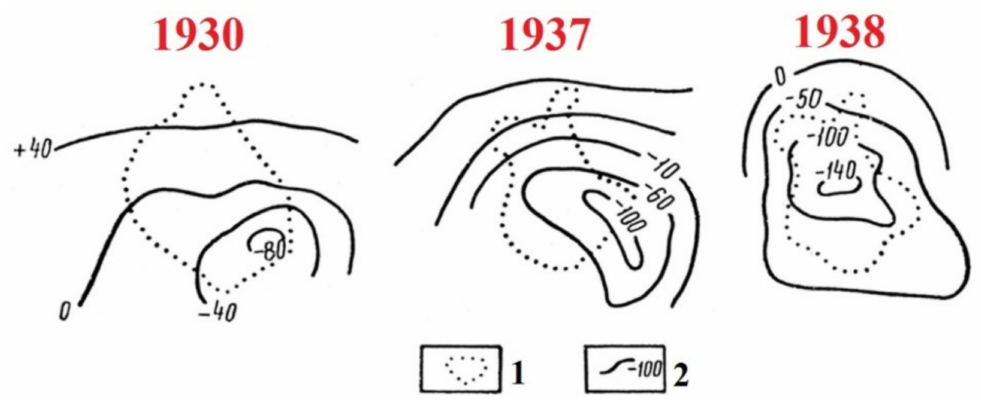
Figure 4. Displacement of self-potential isolines during exploitation of the new shaft of Chyragdere sulfur deposit (Lesser Caucasus) (after [72], with modifications). (1) Stock contour, (2) isolines of self-potential field (in